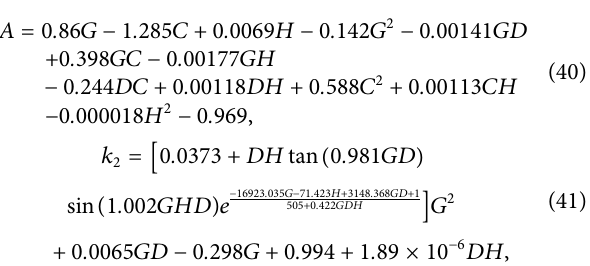
Frontiers in Earth Science |